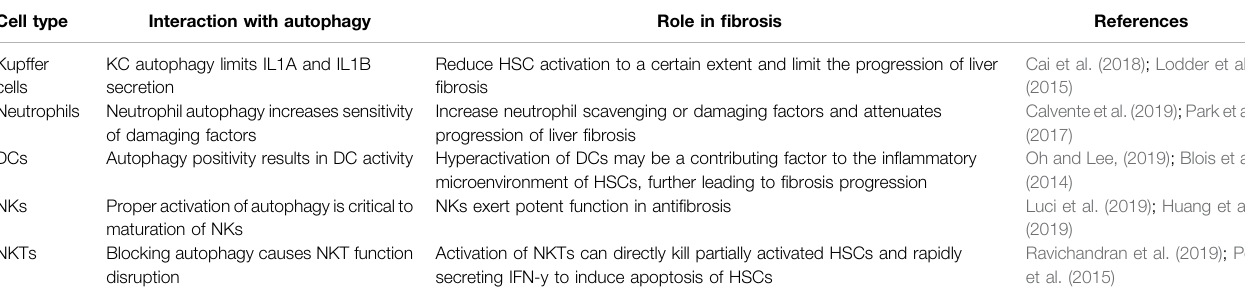
TABLE 1 | Relationship between major innate immune cells and autophagy in liver fi